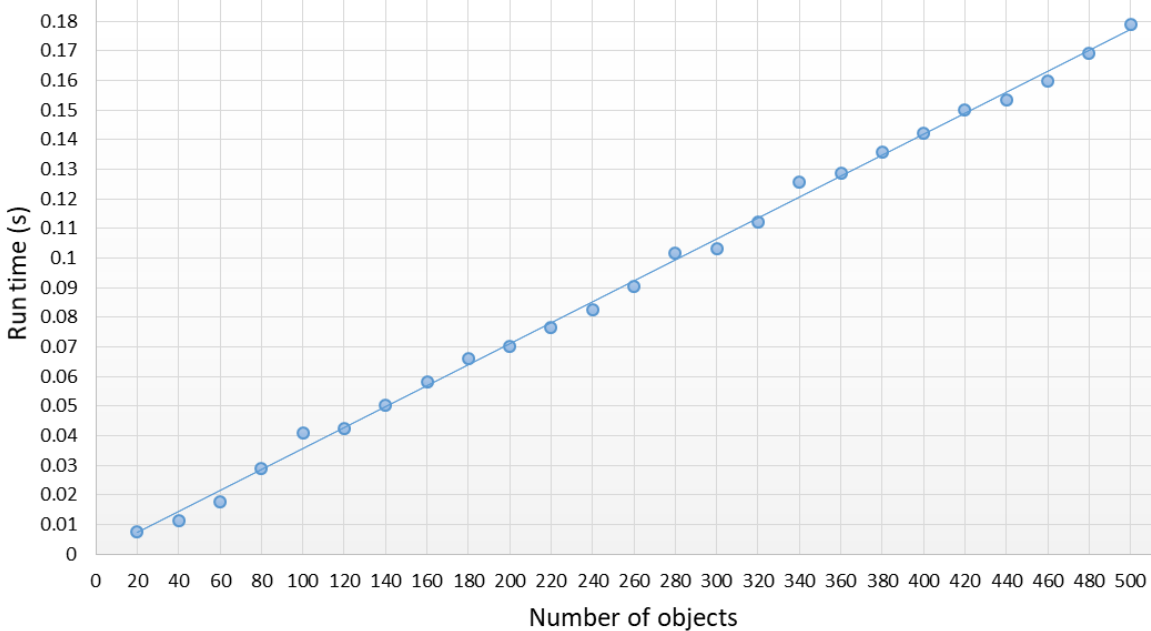
Figure 1. Dependence of the time of calculation of a complex object area on the number of objects.